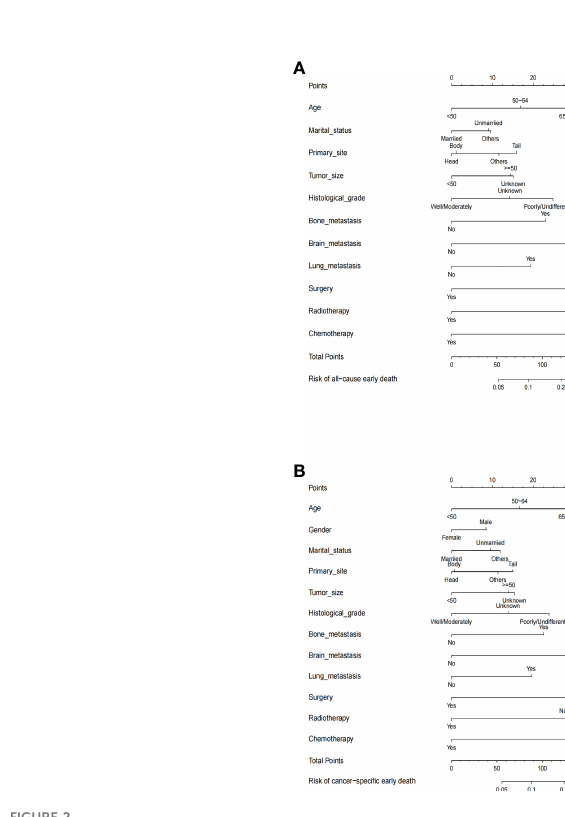
FIGURE 2 The predictive nomogram for (A) all-cause early death and (B) cancer-speci fi c early death of pancreatic cancer liver metastasis patients in the SEER